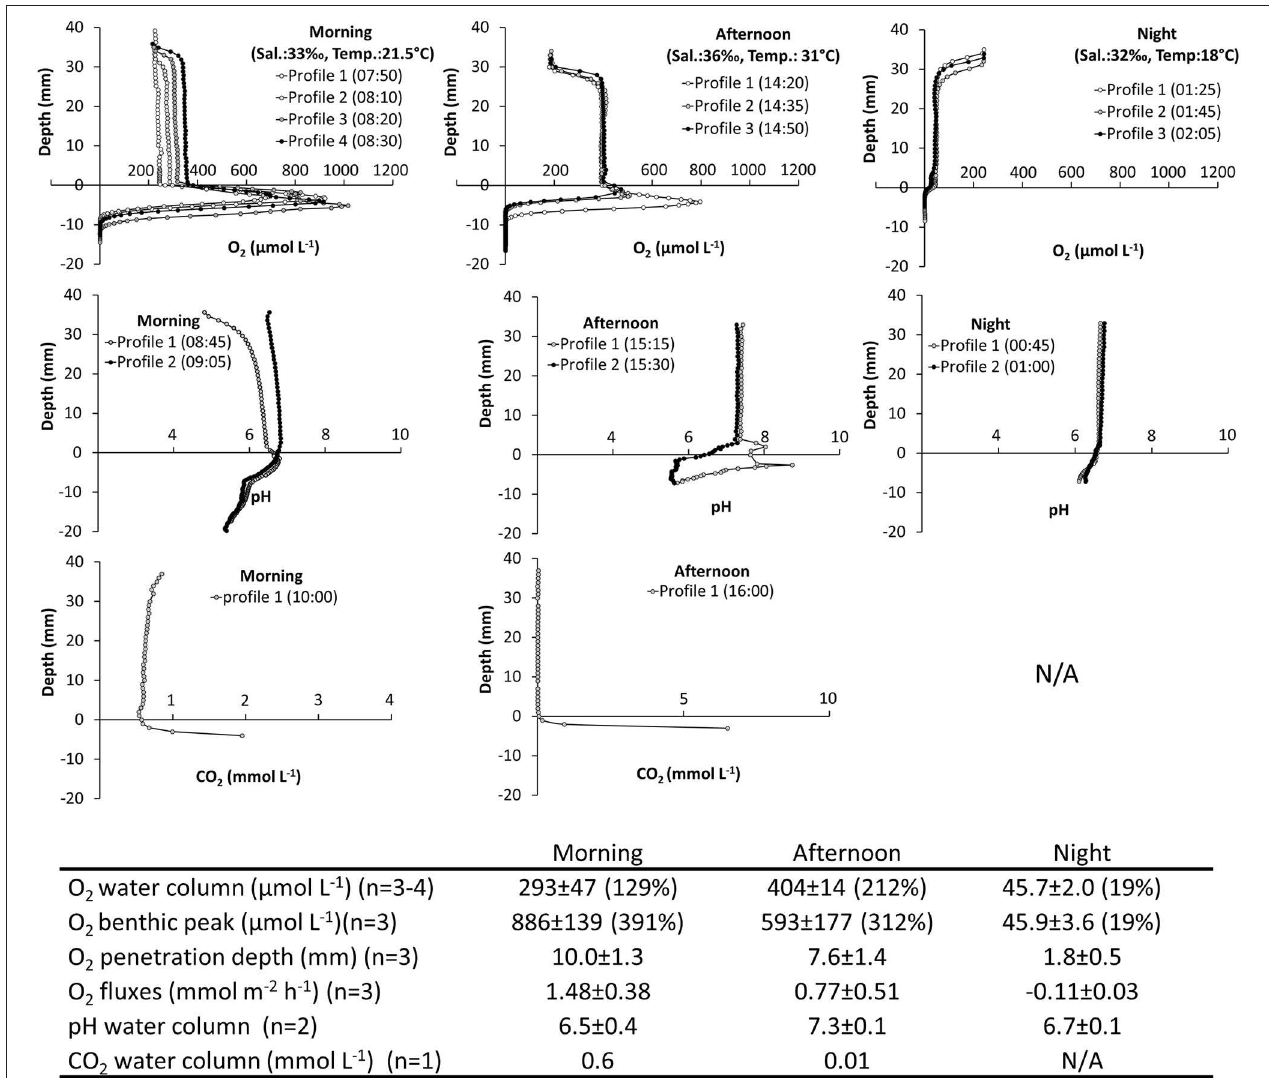
FIGURE 4 | Spatiotemporal variations of O 2 , pH, and CO 2 in a salt marsh tidal pond. In situ investigation. (Top panels) Vertical profiles of O 2 , pH, and CO 2 measured from the air-water interface through the water-column and into the sediment. Profiles were measured in the morning, afternoon and at night. (Table inlet) Table showing average O 2 , pH, and CO 2 conditions at different times of the day. Percent (%) refers to % O 2 atmospheric saturation. CO 2 measurements were not possible at